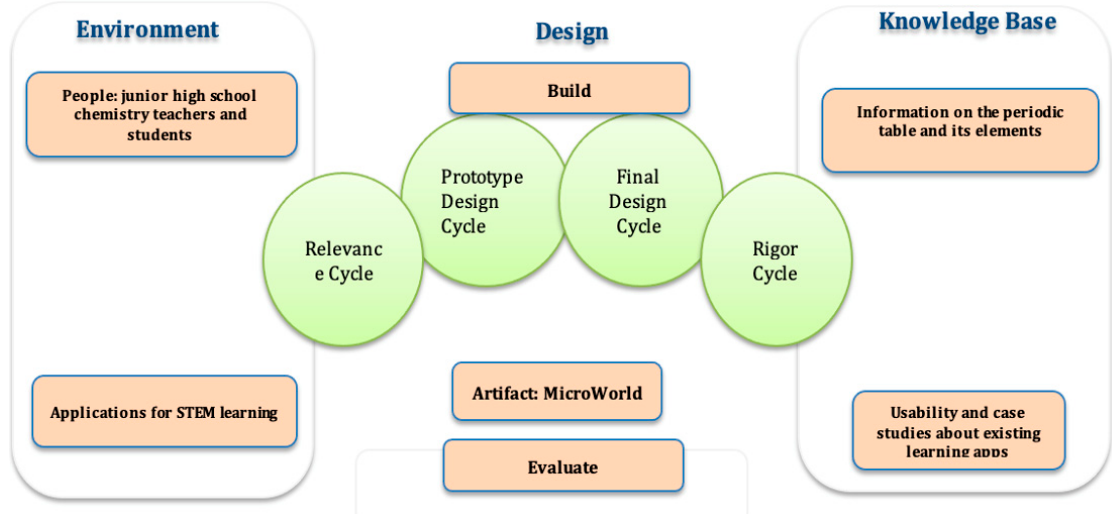
Figure 1. DSR cycle to build and evaluate the MicroWorld app.